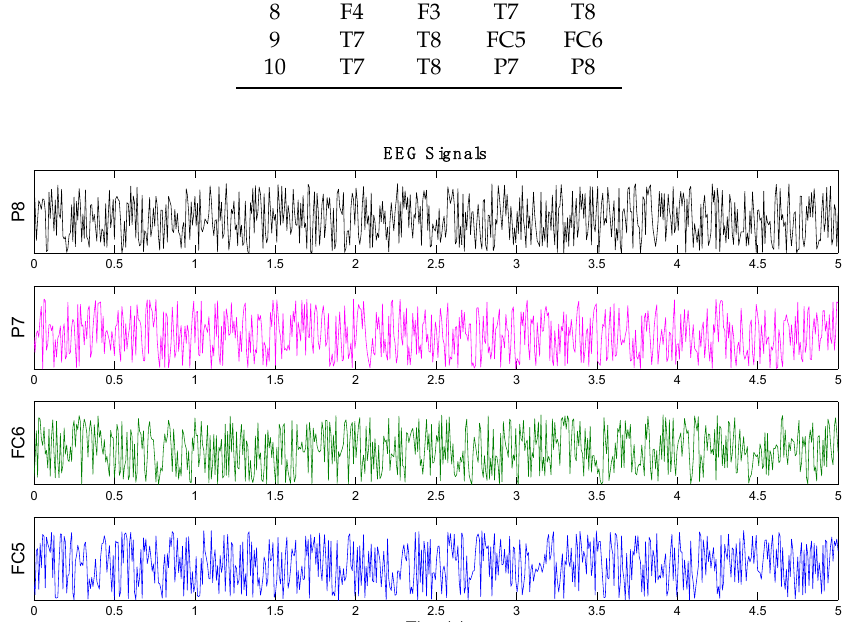
Figure 4. Example of block 1 EEG signals from four channels captured by the Emotiv Epoc device for 5 s.